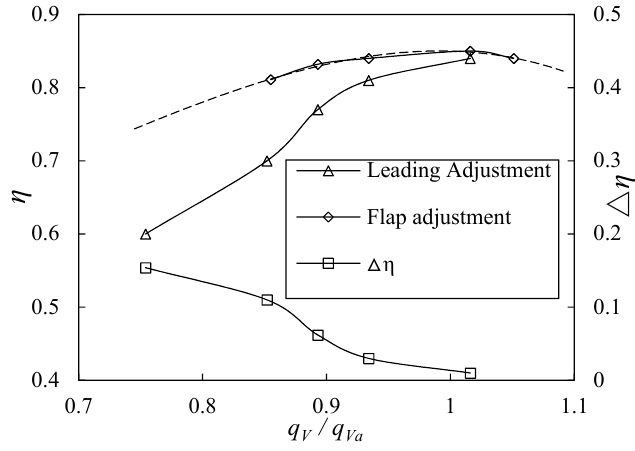
Figure 11. Efficiency of two adjustment in the same pipe-resistance.